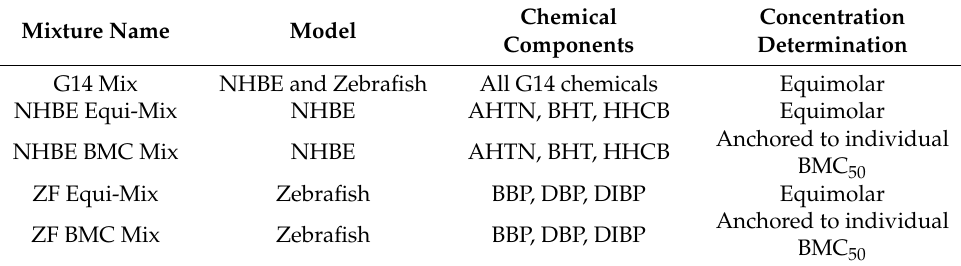
Table 6. Description of each mixture screened in NHBE and